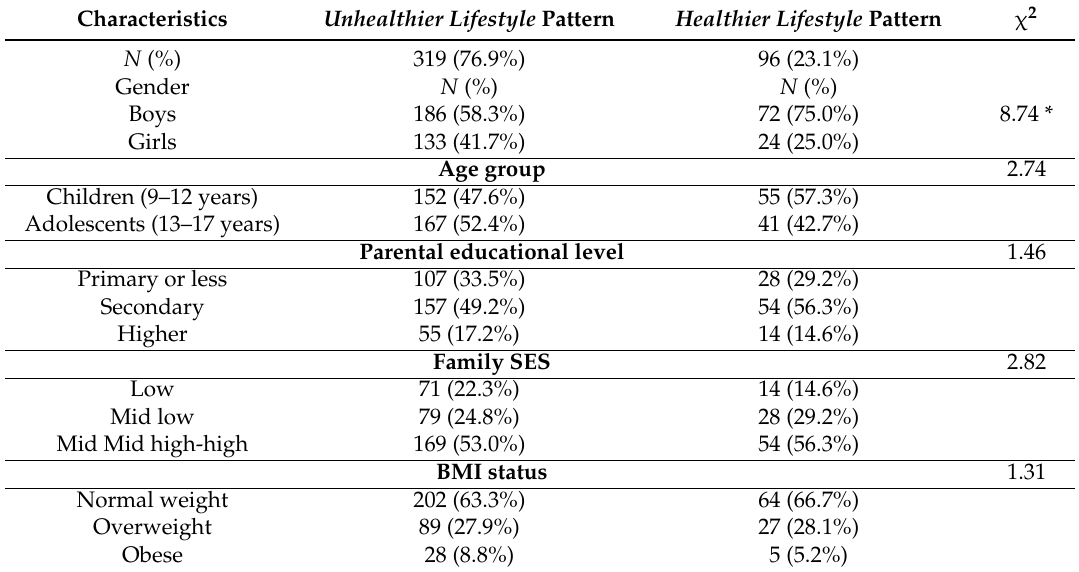
Table 1. Gender, age group, family educational and SES levels, and BMI status, by lifestyle pattern a .